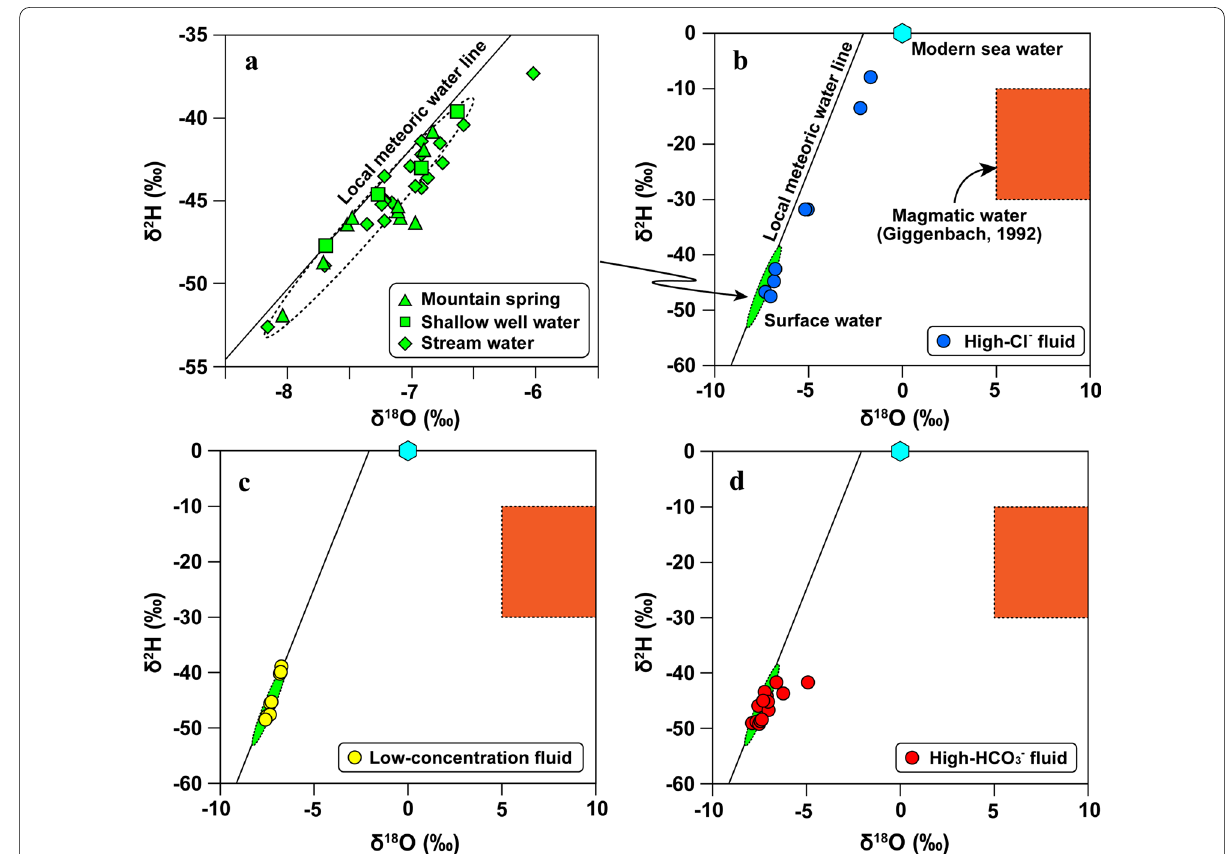
Fig. 3 δ 2 H versus δ 18 O diagrams. a – d Isotopic signatures for the surface waters, High-Cl − , Low-concentration, and High-HCO 3 − fluids, respectively. Isotopic compositional field for hypothesized magmatic water is after Giggenbach (1992). Local meteoric water line in Kumamoto (ca. 20 km northeast from Uto district) is after Okumura et al.